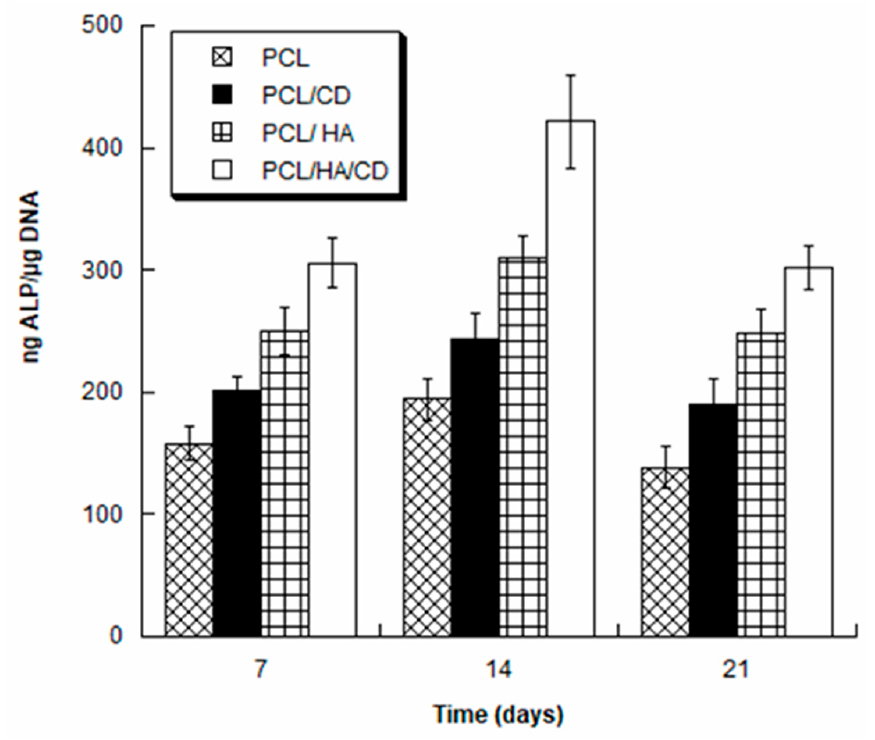
Figure 8. Normalized ALP activity (ALP/DNA) for PCL, PCL/CD, PCL/HA, PCL/HA/CD at 7, 14 and 21 days.